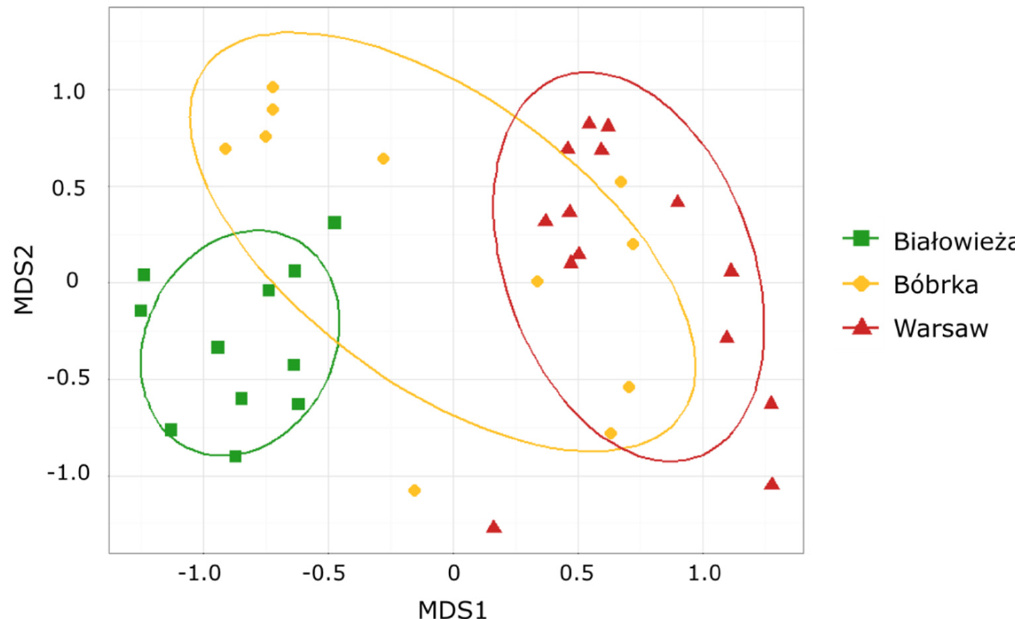
Figure 1. NMDS analysis of the fungal ARISA fingerprints with the Bray–Curtis distance metric (stress = 0.17) of the Białowie˙za National Park, the crude-oil-polluted site of B ó brka, and the city center of Warsaw. Probability ellipses (standard deviation, p = 0.68) are shown for each site considered as geographically separated.